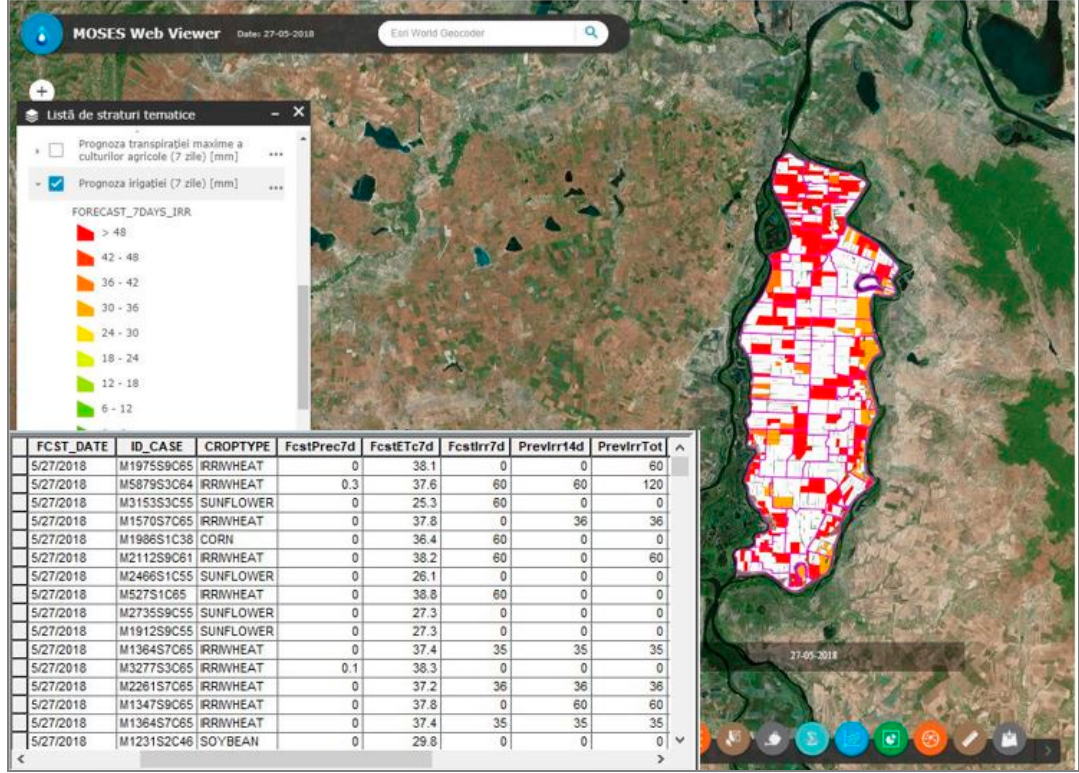
Figure 6. Example of short-term irrigation forecast available on MOSES webGIS application, Embanked Great Island of Danube River, Br ă ila.